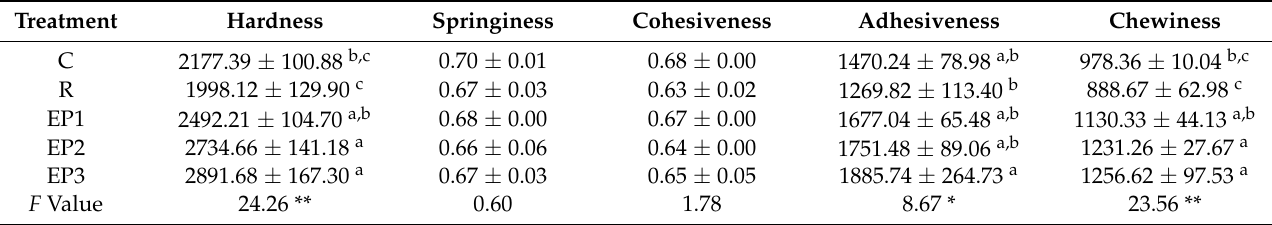
Table 6. Texture profile analysis of the pork